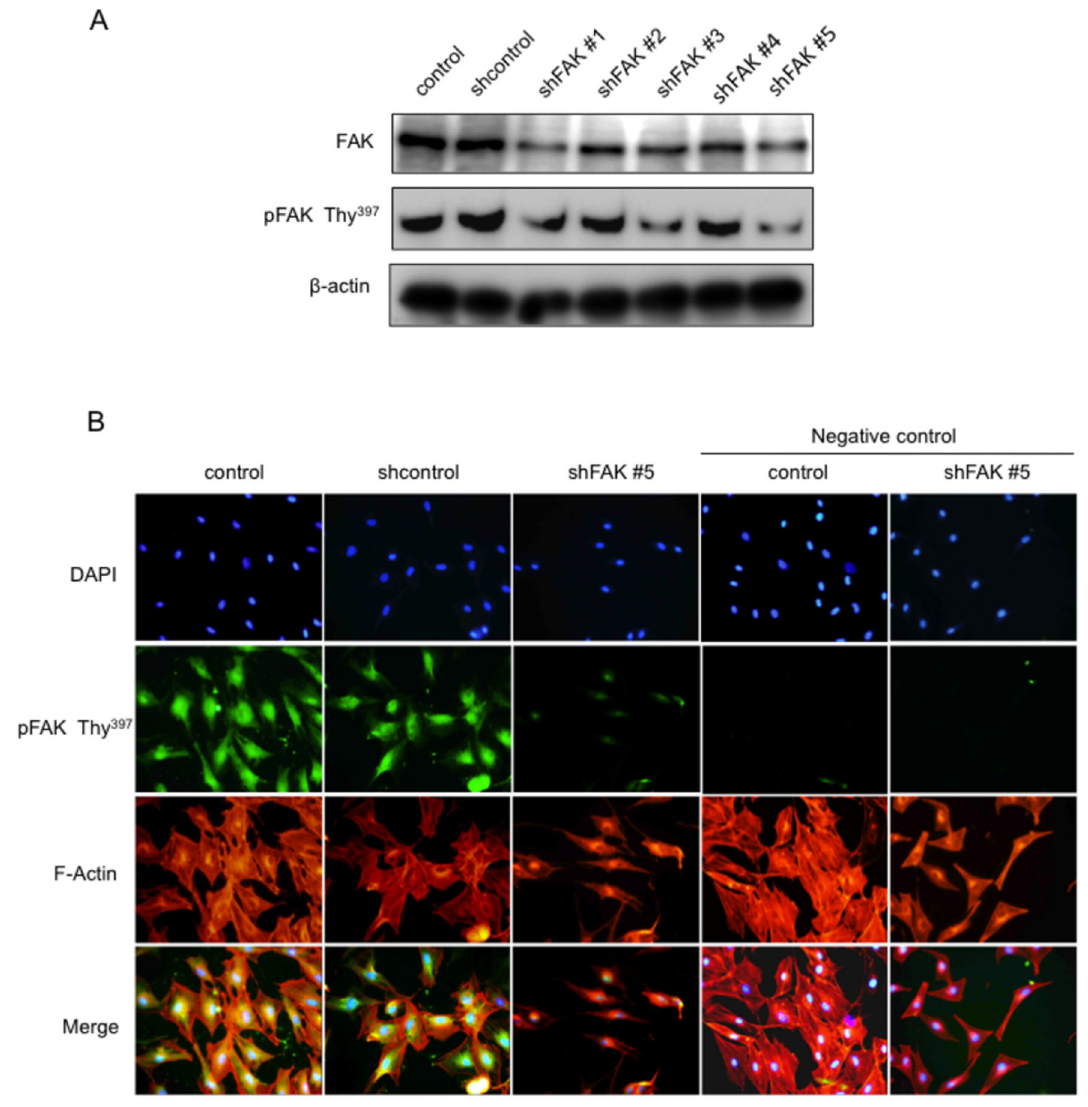
Figure 4. Effect of FAK knockdown by short-hairpin FAK RNAs on MC3T3-El cells and on their morphology. A, Immunoblot analysis of FAK and pFAKTyr 397 expression in short-hairpin FAK RNA (shFAK #1-#5)-infected MC3T3-El cells. Control, non-infected MC3T3-E1 cells. Shcontrol, control shRNA-infected group. B, Immunofluorescence staining for pFAK Tyr 397 (green) and F-actin (red) and 4’6’-diamidino-2-phenylindole staining (blue) in control, shcontrol and shFAK#5 RNA-infected MC3T3-El cells. Negative control group was treated with antibody dilution buffer minus pFAKTyr 397 antibody. The data from a typical experiment are presented; similar results were obtained in repeated